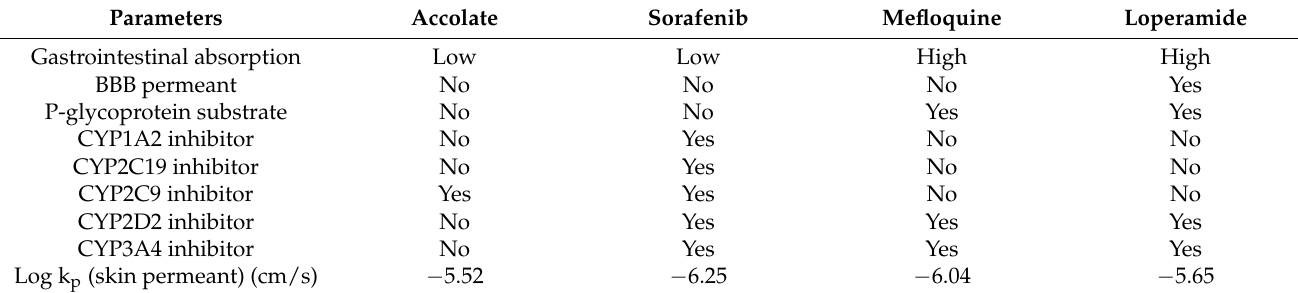
Table 3. Pharmacokinetics parameters for the